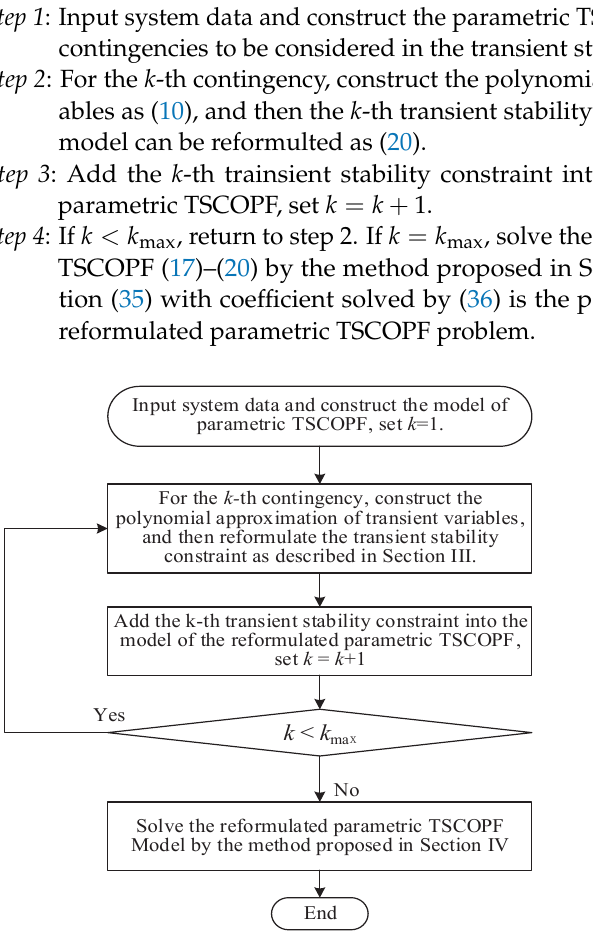
Figure 2. Flowchart of SCM-based polynomial approximation for solving parametric TSCOPF